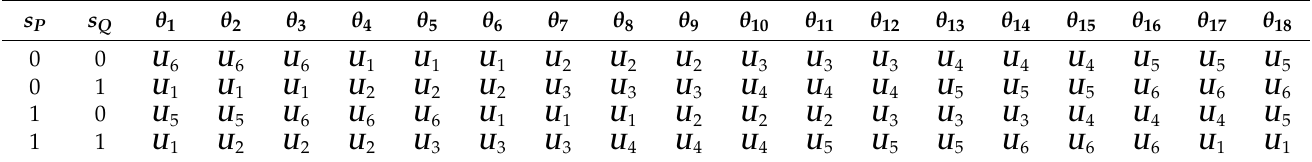
Table 4. Switching table based on the optimized 18-sector